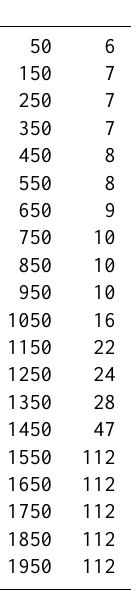
Table 1. Number of grid points containing observational data, at 100yr intervals through the last two